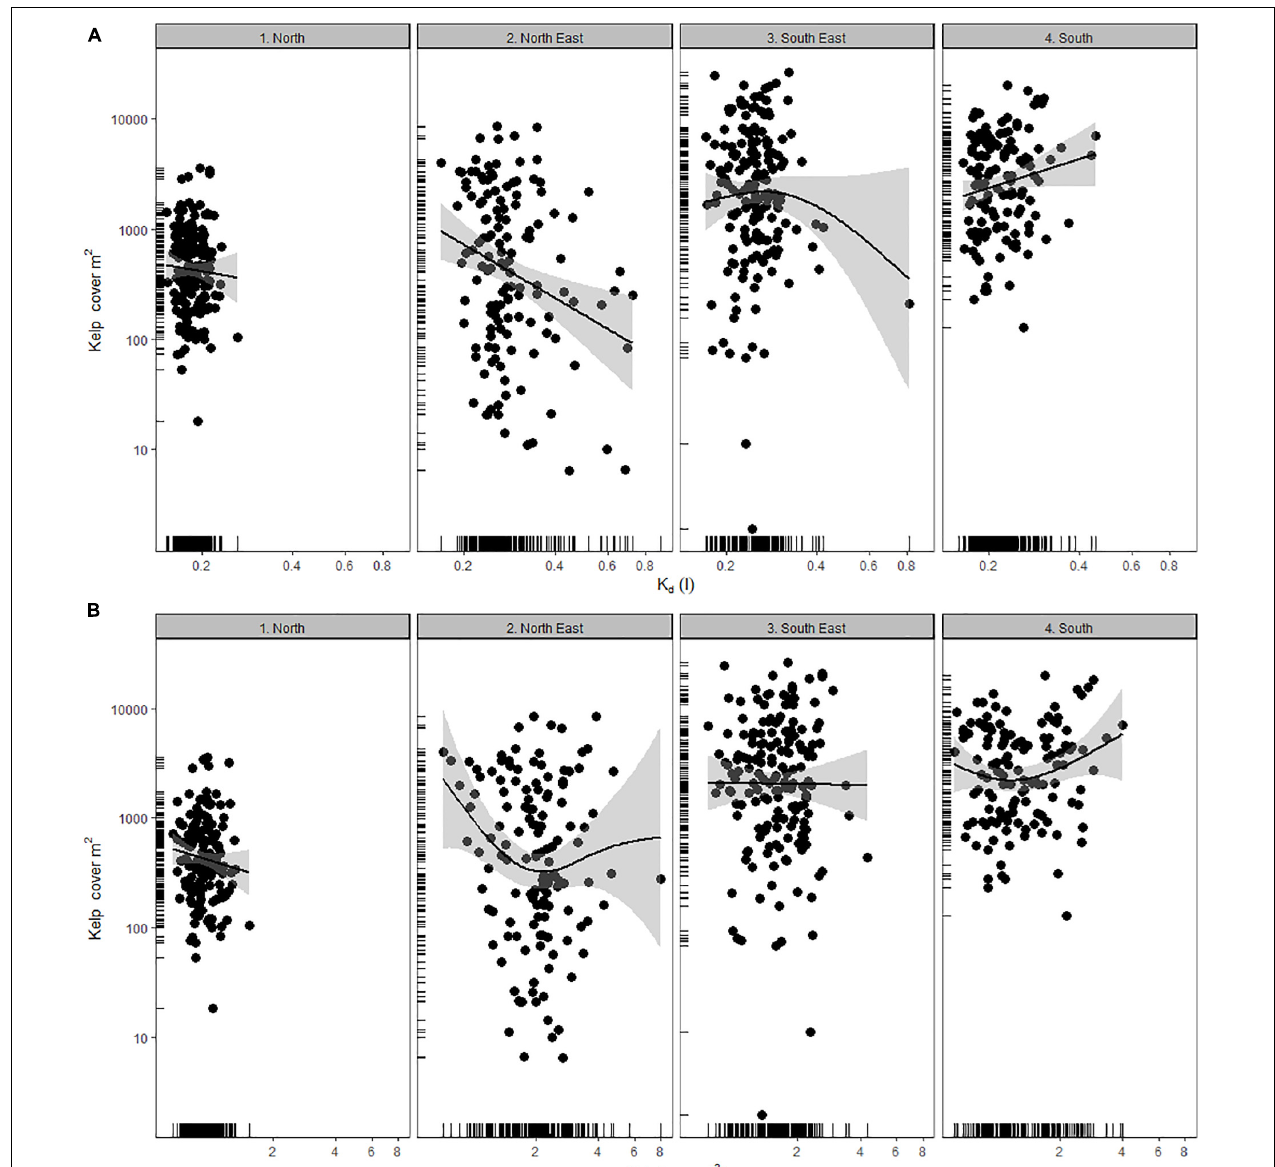
FIGURE 3 | Macrocystis pyrifera surface canopy cover as related to clarity- K d (A) , and chl- a concentrations (B) , across four regions (1–4). Y-axis and x-axis are log transformed. Relationships are fitted by GAM with standard